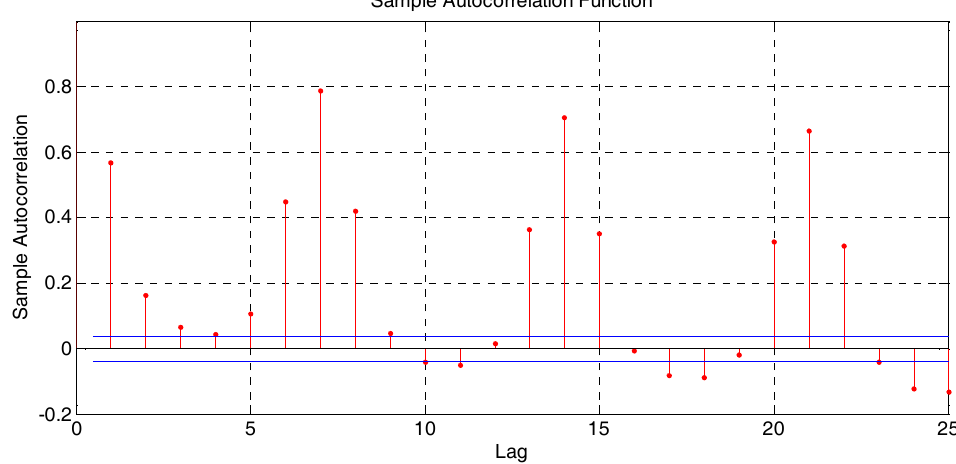
Figure 4. Sample autocorrelation function for National load at 18 h.